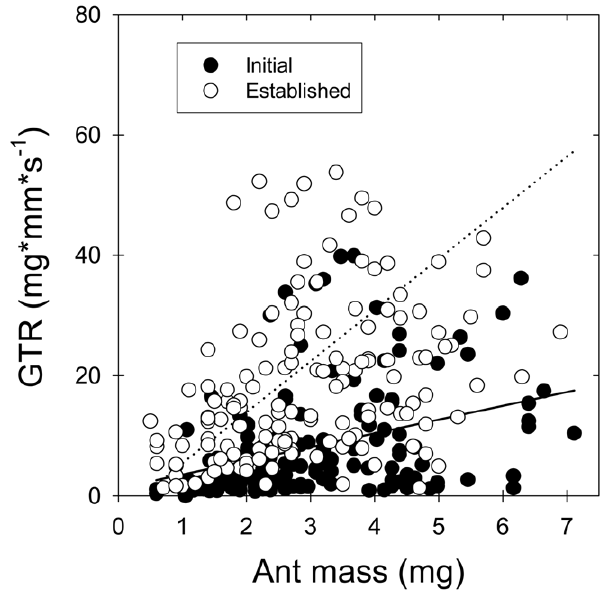
Figure 6. Gross transport rate of plant tissue (expressed as mass carried per mm and per second) as a function of ant body mass, for both the initial and established foraging phases. Data were Q 10 -transformed at 15 u C (further details in